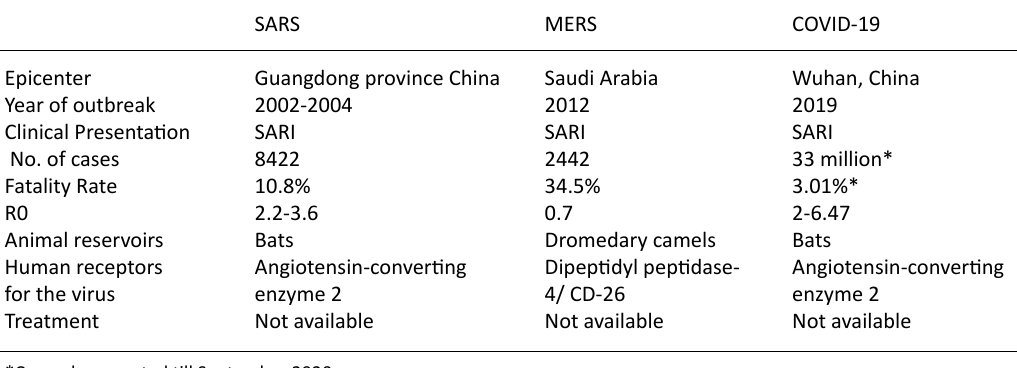
table 1. Comparison of three coronavirus diseases: SARS, MERS and